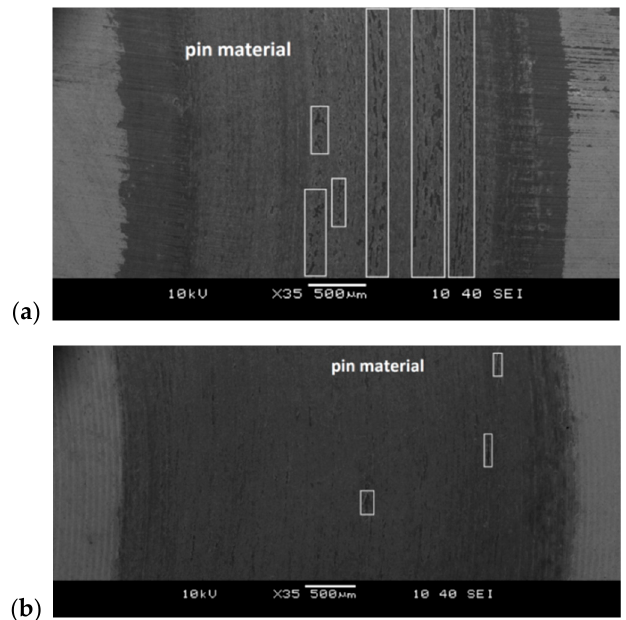
SN; 19MnB4 steel pins as counterbodies were used.